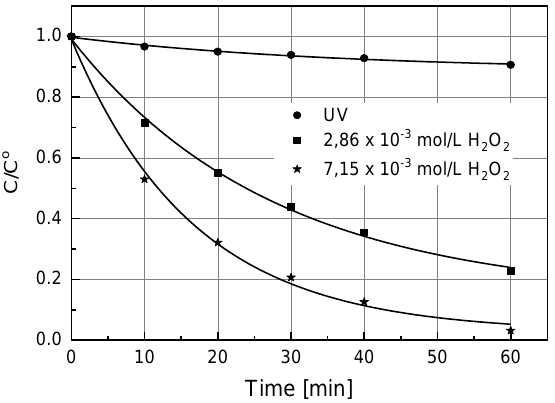
Figure 2. Salicylic acid concentration changes with oxidation time at different H 2 O 2 doses, temperature 25 °C.